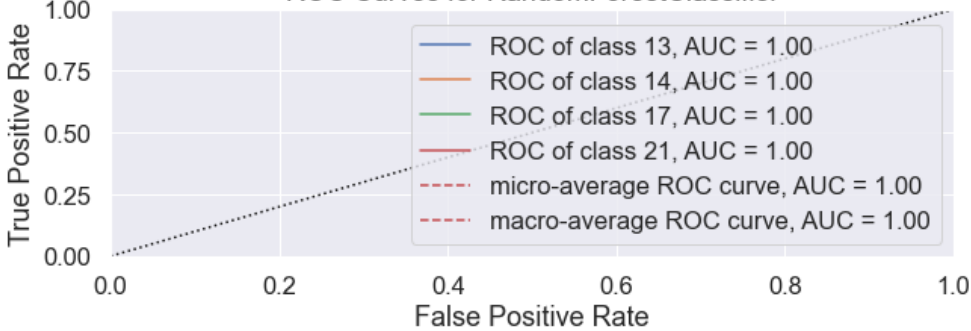
Figure 11. RF preset-subsets prediction performance evaluation using ROC curve.